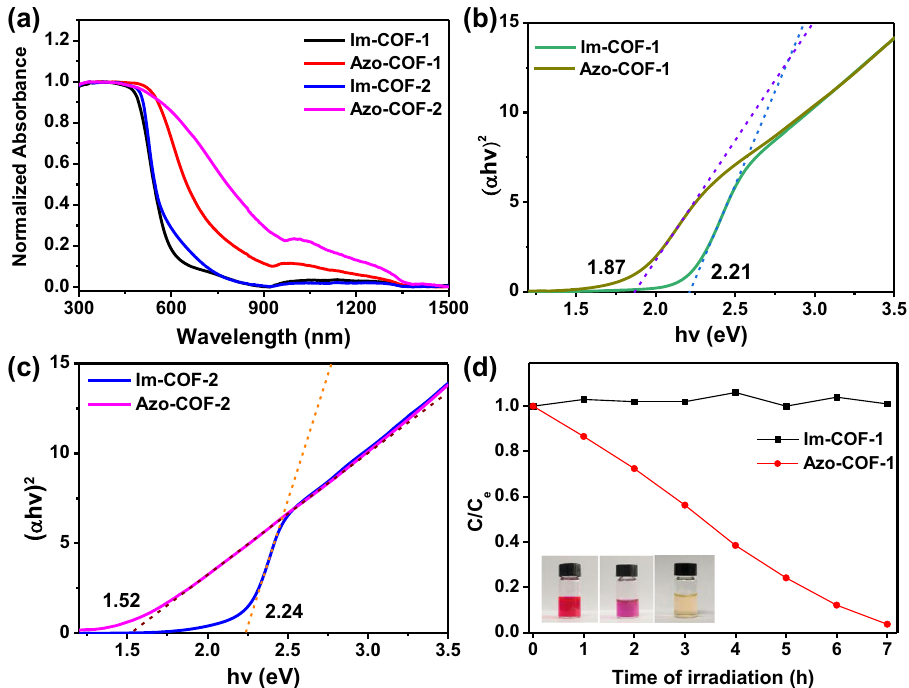
Fig. 5 Photophysical and photocatalysis properties. a Solid-state UV – vis – NIR DRS. b , c Tauc plot analysis of the COFs. d Comparison of the performance of Im-COF-1 and Azo-COF-1 on photocatalytic degradation of Rh B. Inset: photograph of Rh B solutions of pristine (left), and after photodegradation catalyzed by Im-COF-1 (middle) and Azo-COF-1